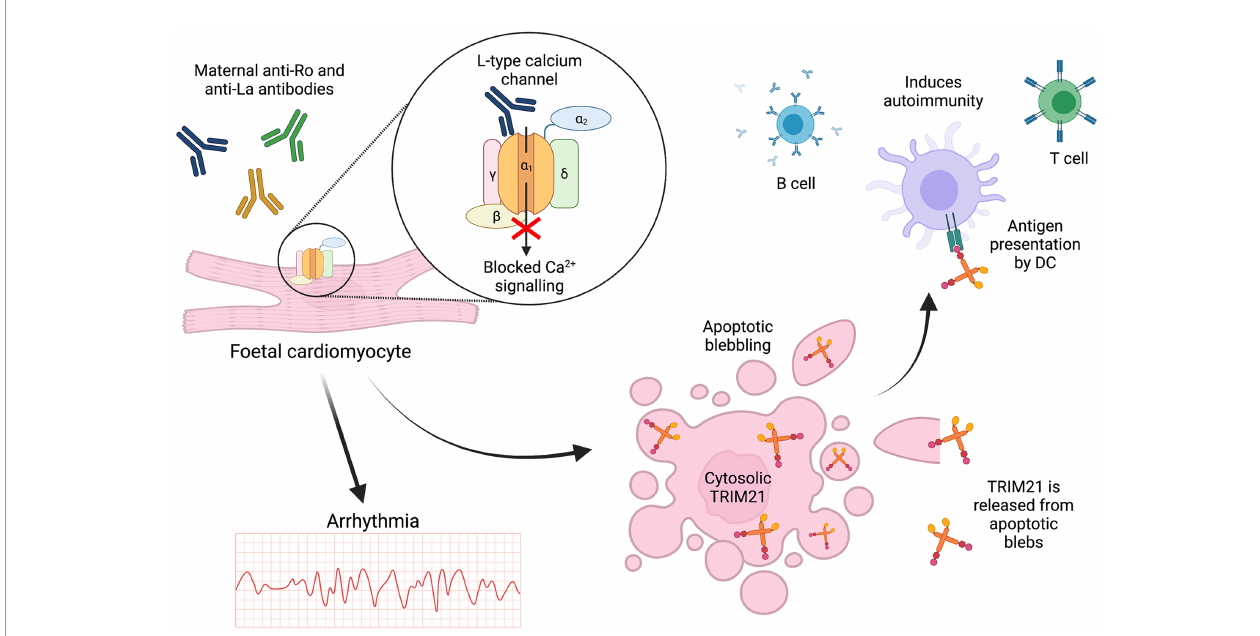
FIGURE 5 | TRIM21 exposure at the cell surface may occur due to apoptosis. In foetal CHB, cross-reactive maternal autoantibodies may bind to and block L-type calcium channels leading to arrhythmia and cardiomyocyte apoptosis. This releases intracellular antigens such as TRIM21 for antigen presentation, driving subsequent